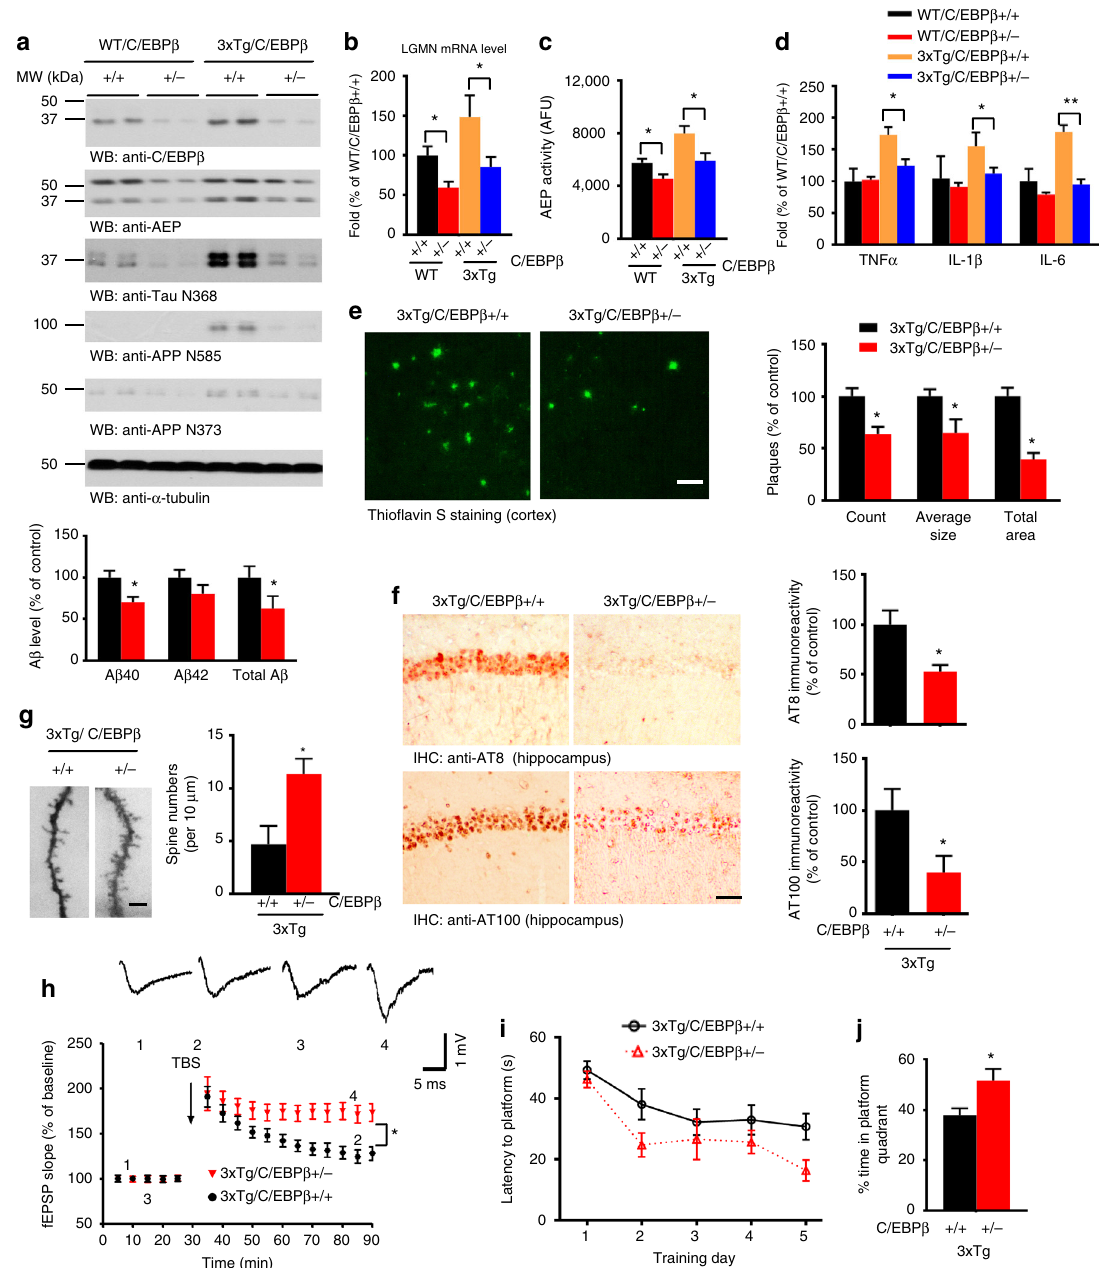
Fig. 7 Reduction of C/EBP β gene dose reverses AD-like pathologies and alleviates cognitive impairments in old 3xTg mice. a Reduction of C/EBP β decreases delta-secretase and APP and Tau cleavage by delta-secretase. The hippocampal tissues were analyzed by immunoblotting ( n = 2 mice per group). b , c Reduction of C/EBP β reduces delta-secretase mRNA and enzymatic activities. Data represent mean ± s.e.m. of three mice per group (* P < 0.05, one-way ANOVA). d Reduction of C/EBP β decreases expression levels of in fl ammatory cytokines. Data represent mean ± s.e.m. of three mice per group (* P < 0.05, ** P < 0.01, one-way ANOVA). e Amyloid plaques are decreased in 3xTg/C/EBP β + / − mice. Thio fl avin S staining showing the A β plaques in the frontal cortex (left panels). Scale bar, 50 μ m. Plaque analysis data represent mean ± s.e.m. of 12 – 19 sections from three mice in each group (right, * P < 0.05, Student ’ s t -test). A β ELISA represent mean ± s.e.m. of three mice per group (lower, * P < 0.05, Student ’ s t -test). f Tau pathologies are reduced in 3xTg/C/EBP β + / − mice. The brain sections of 3xTg and 3xTg/C/EBP β + / − mice (10 months old) were immunostained with AT8 (upper left panels) and AT100 antibody (lower left panels) (mean ± s.e.m.; 12 – 18 sections from three mice, * P < 0.05, Student ’ s t-test). Scale bar, 50 μ m. g Spine density in the hippocampus determined by Golgi staining (mean ± s.e.m.; n = 4; * P < 0.05, Student ’ s t -test). Scale bar, 5 μ m. h Electrophysiology analysis. C/EBP β reduction in the hippocampus rescued the LTP defects in aged 3xTg mice (mean ± s.e.m.; n = 6 in each group; *P < 0.05, Student ’ s t-test). Shown traces are representative fEPSPs of four samples recorded at the time points 1 and 2 (3xTg/C/EBP β + / + ) and 3 and 4 (3xTg/C/EBP β + / − ). i , j Morris water maze analysis of cognitive functions. C/EBP β reduction in the hippocampus rescues the learning and memory impairments in 3xTg mice (mean ± s.e.m.; n = 8 mice per group; * P < 0.05, Student ’ s t